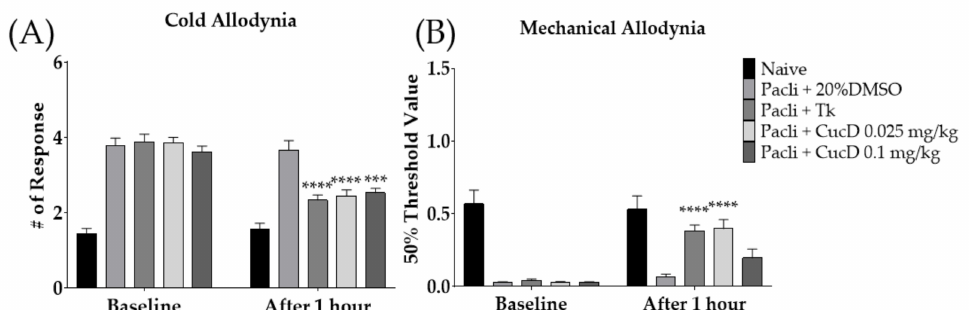
Figure 7. Efficacy of cucurbitacin D (CucD), a component of Tk, on paclitaxel-induced neuropathic pain ( A , B ). Efficacy of Tk (500 mg/kg) and CucD (0.025 and 0.1 mg/kg) were investigated 1 h after its treatment. 20% DMSO was used as a control of CucD (i.p.). Tk was orally administered as a positive control. CucD: Cucurbitacin D, Tk: Trichosanthes kirilowii Maximowicz. Naive: n = 6, Pacli + 20%DMSO: n = 6, Pacli + Tk: n = 6, Pacli + CucD 0.025 mg/kg: n = 6, Pacli + CucD 0.1 mg/kg: n = 6. *** p < 0.001, **** p < 0.0001 vs. Baseline with two-way ANOVA followed by Sidak’s post-test for multiple